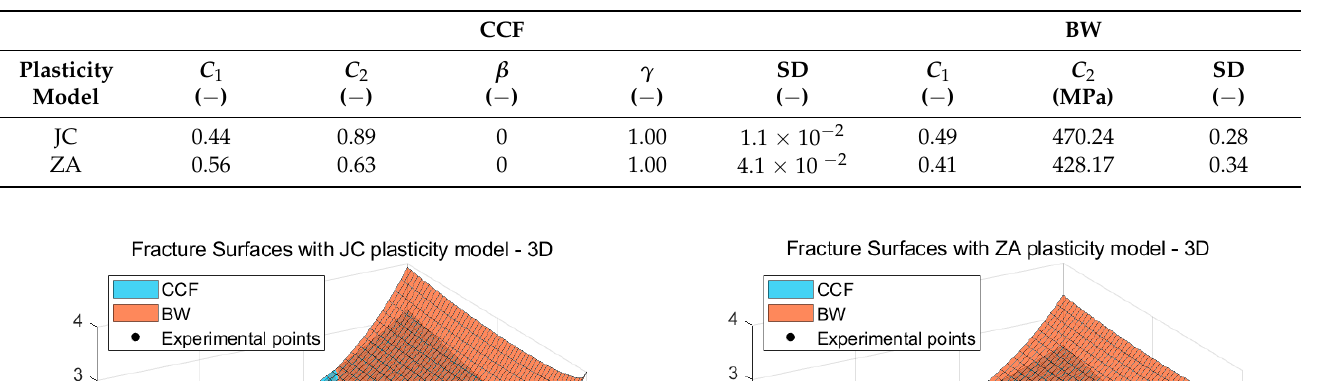
Table 7. Values of the material damage parameters and the standard deviation (SD) of the minimization.